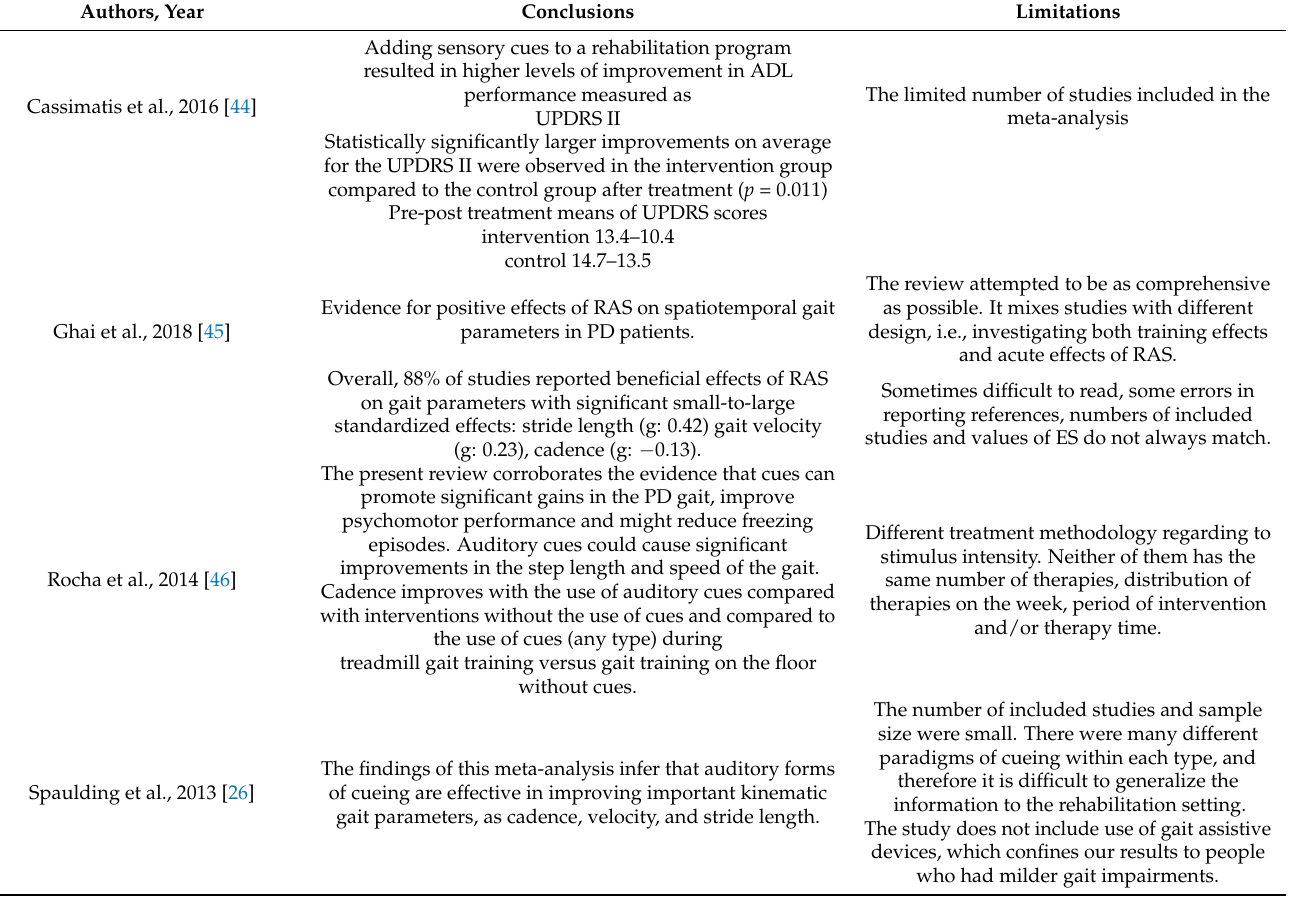
Table 4. Conclusions and limitations of selected